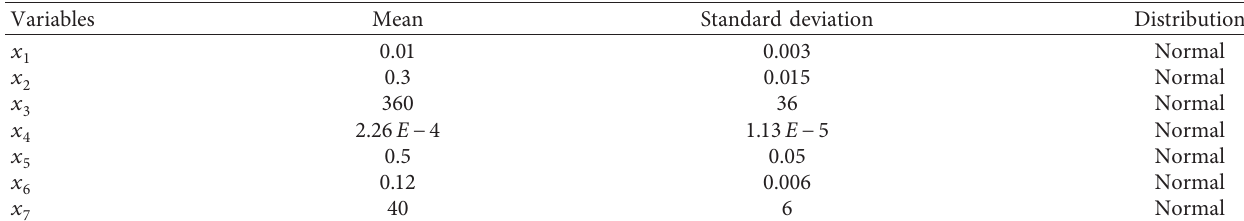
Table 4: The mean and standard deviation of the random